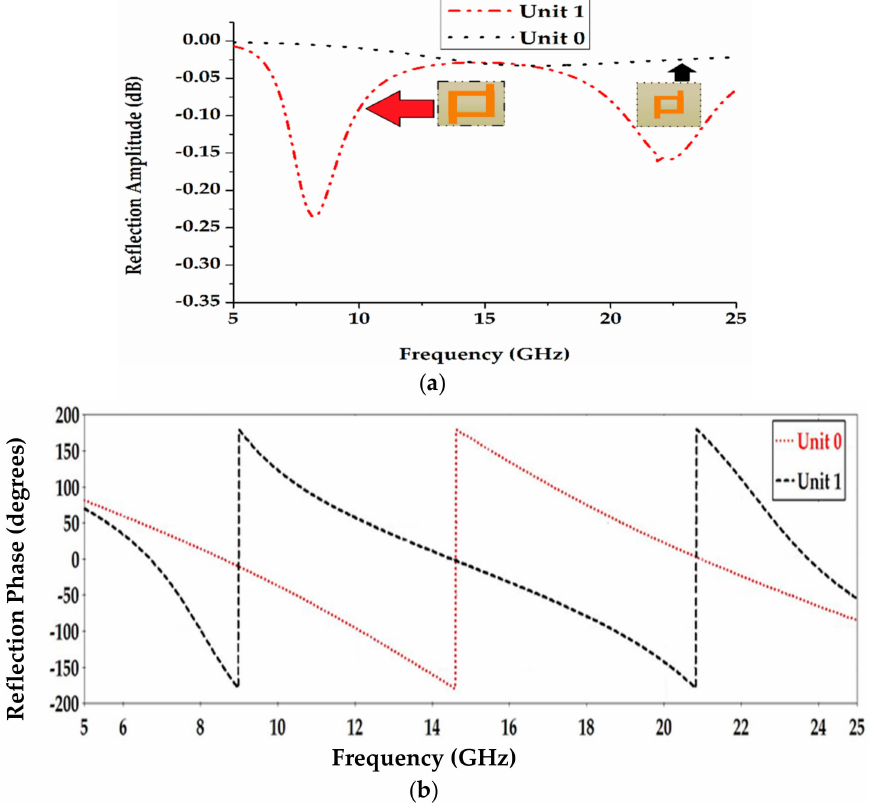
Figure 2. ( a ) Reflection magnitudes of unit cells ‘1’ and ‘0’; ( b ) Reflection phase of the unit cells ‘1’ and